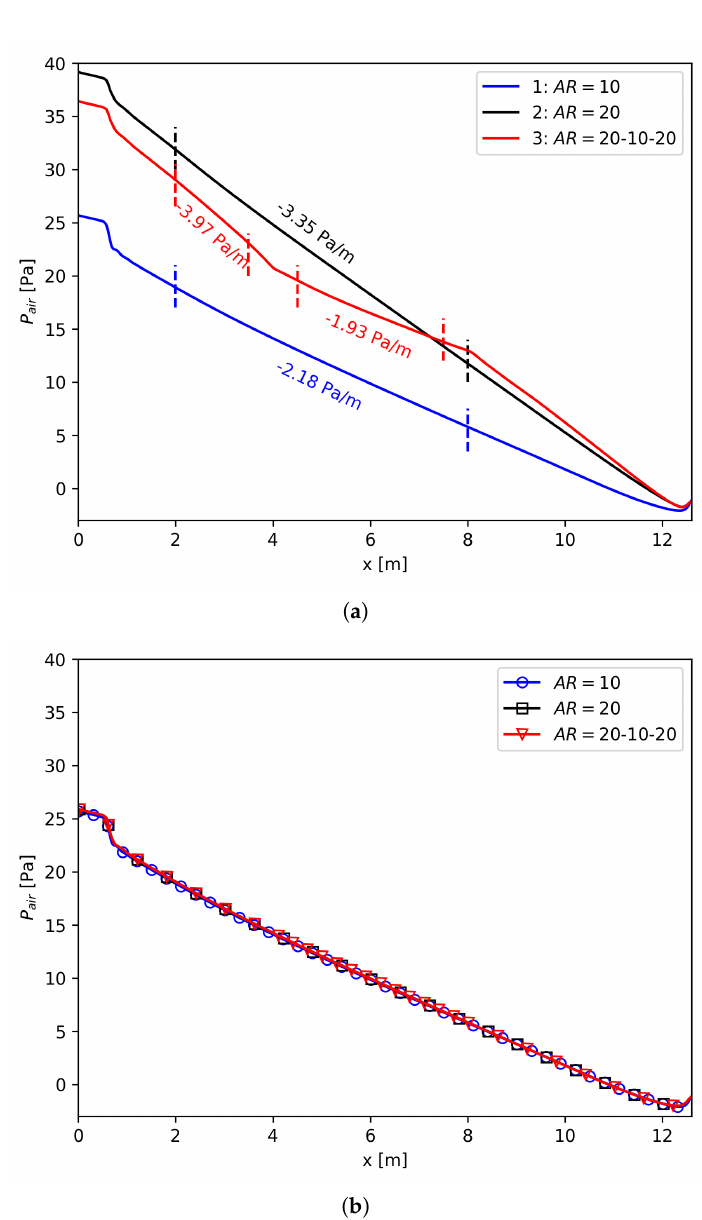
Figure 7. Axial pressure profiles for meshes with AR = 10, 20, and 20-10-20. Top: B 3 √ the aspect ratio of the cells; it performs worse for non-uniformly-distributed cells. Bottom: B y much less dependency on the aspect ratio of the cells. ( a ) B 3 √